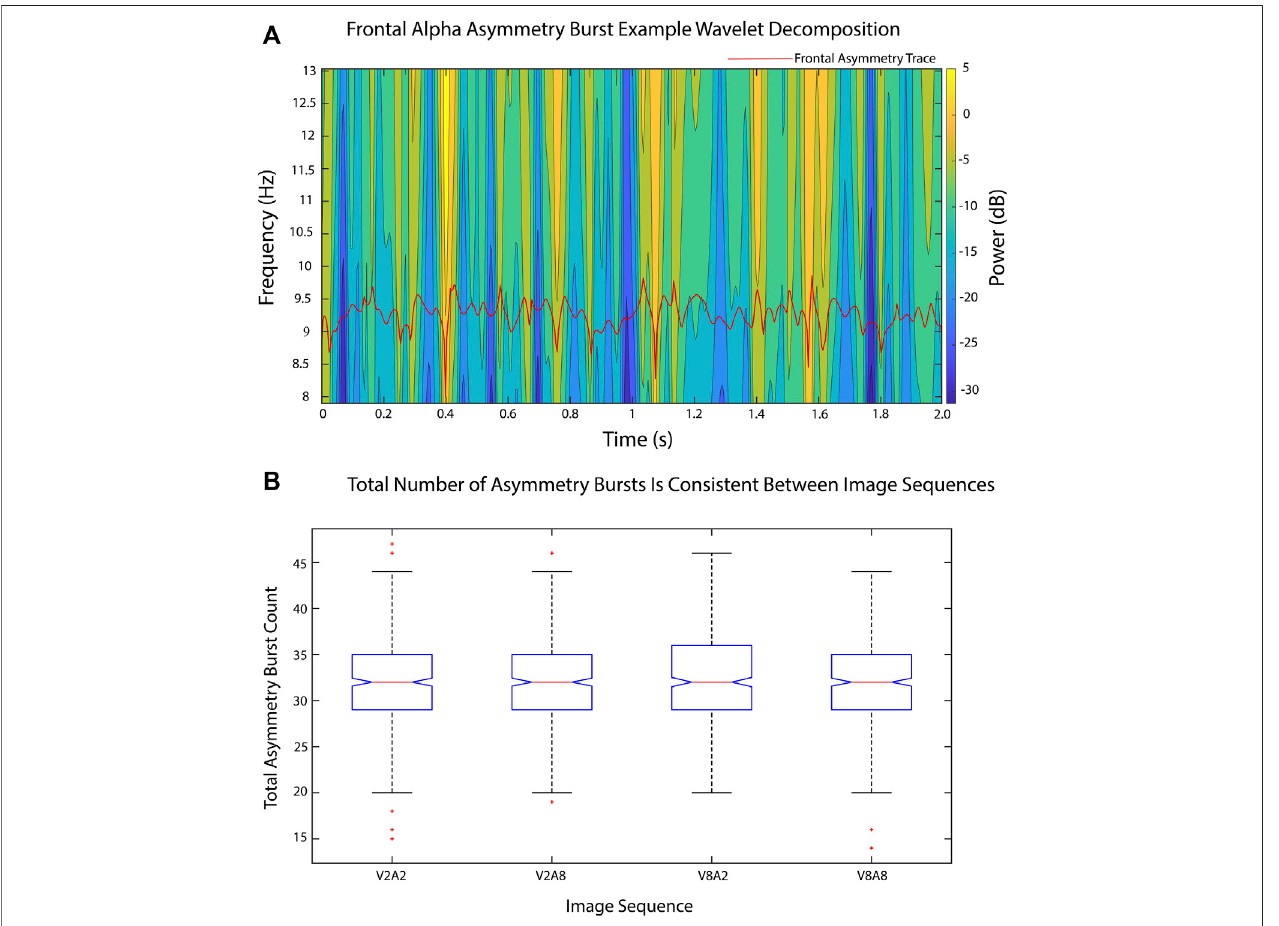
FIGURE 8 | FAA temporal dynamics were analyzed using FAA burst measures. (A) A sample time-frequency wavelet decomposition from an FAA time series (red) from one epoch of one image sequence (V2A2). Time-frequency power was smoothed via convolution with a Gaussian kernel with a standard deviation of 2 to ease viewing. Power calculations were performed on raw data. (B) . Total number of FAA bursts remained consistent between valence and arousal image sequence levels.